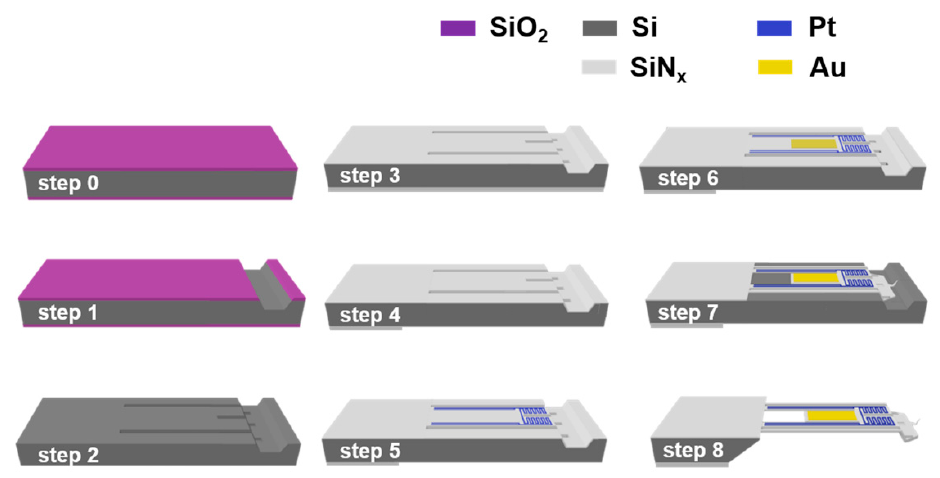
Figure 1. Schematic of the MEMS process for probe fabrication.